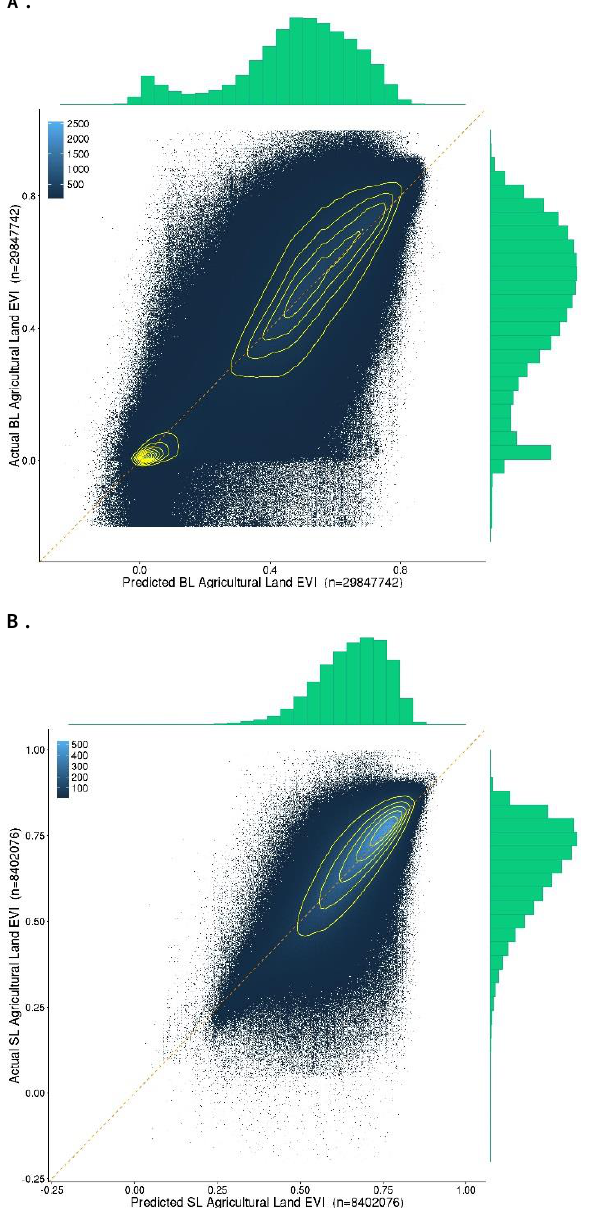
Figure 3: Correlation between predicted and actual EVI in (A) Bangladesh and (B) Sri Lanka across measured values of